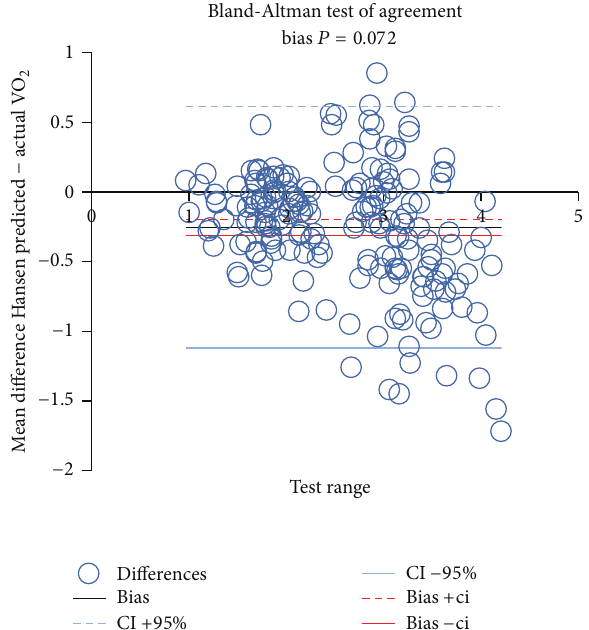
Figure 3: Illustration of Bland-Altman test of agreement between Hansen predicted VO 2 max using ideal versus actual body weight in calculations.